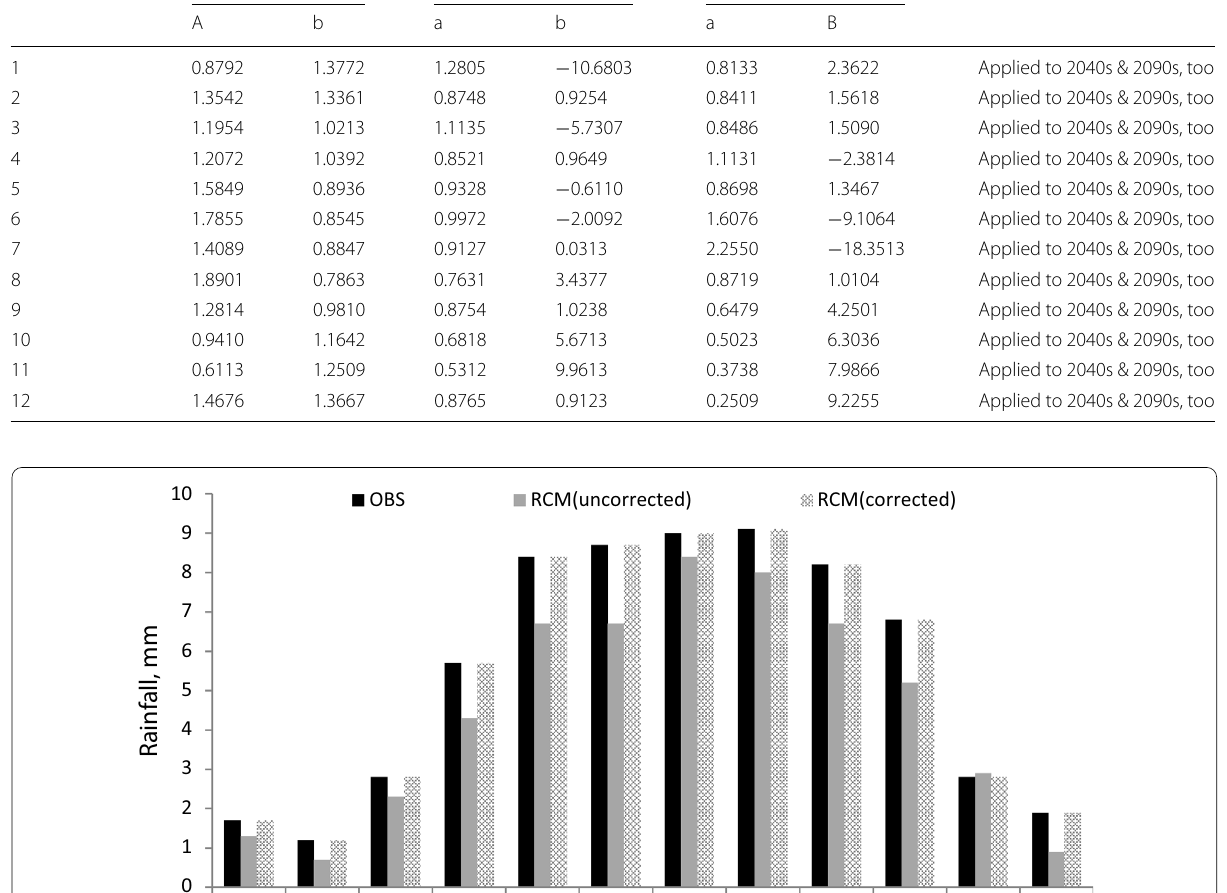
Table 2 Tabular values of correction factors (a and b) used for bias correction Block/month Rainfall Max. temperature Min.